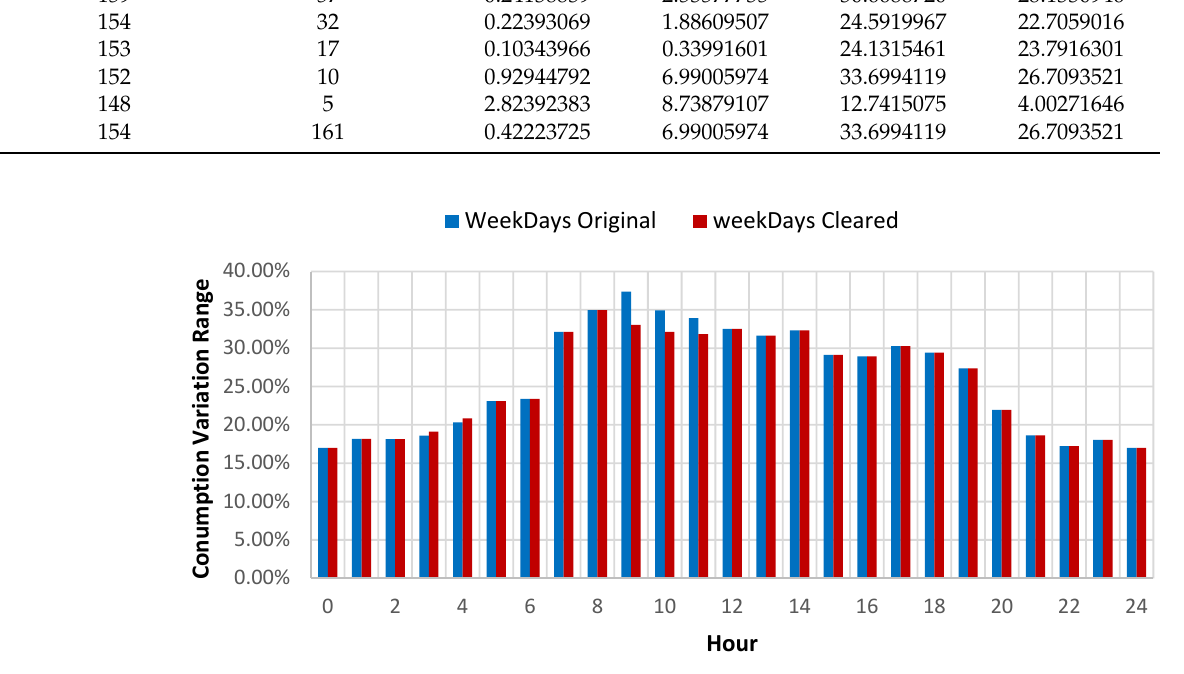
Figure 12. Energy consumption variation range compared to hourly average weekdays consumption for original and cleared data sets.